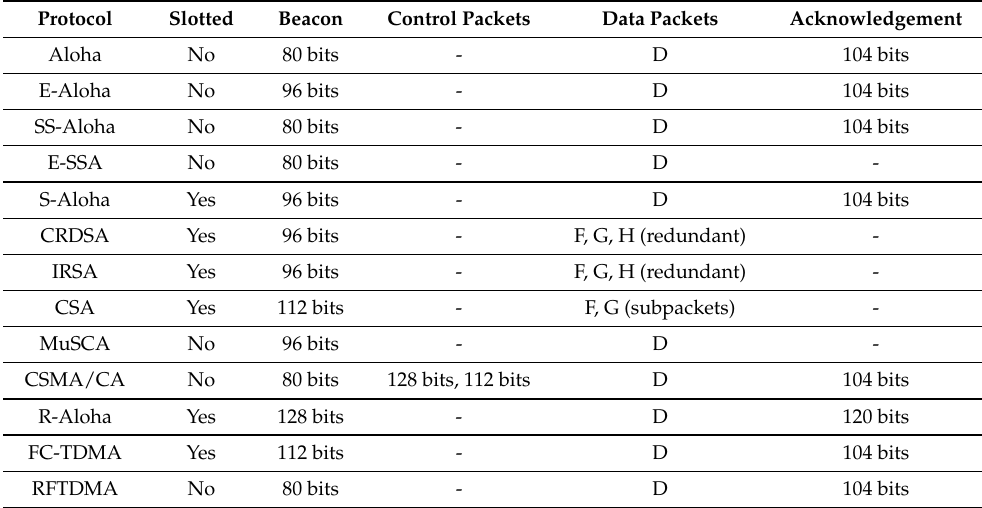
Table 2. Summary of types of packets interchanged in the network for each of the protocols, according to the sequence